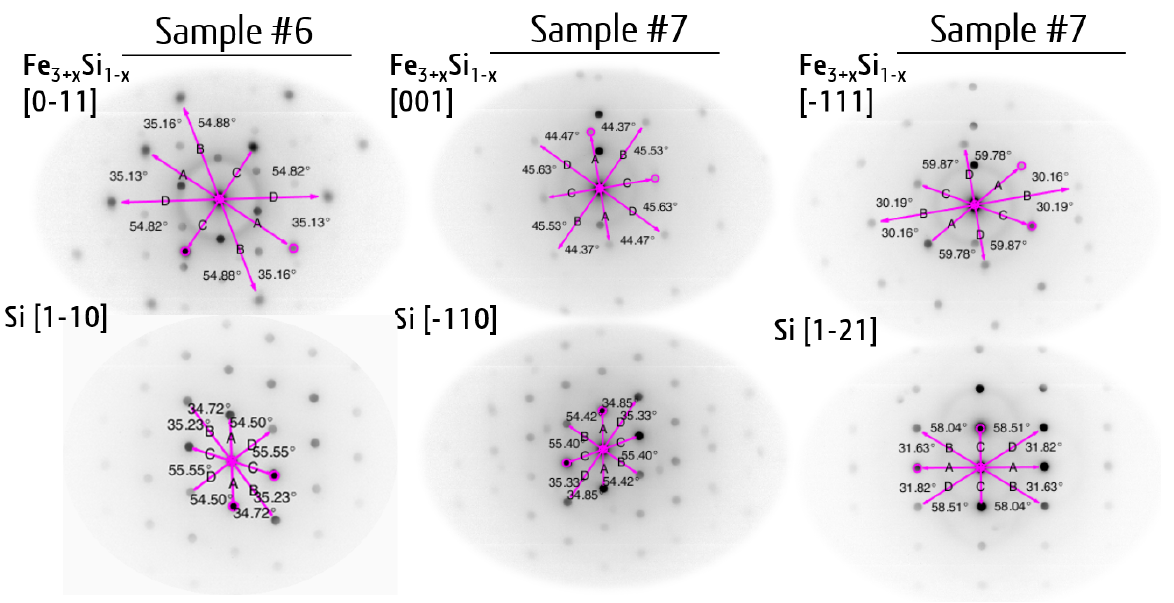
Figure 3. TEM electron diffraction pattern of cross-section of Fe 3+ x Si 1 − x /Ge/ Fe 3+ x Si 1 − x /Si(111) samples #6 and #7 along different projections (zone axes). The angles of reciprocal lattice vectors are given for each phase .